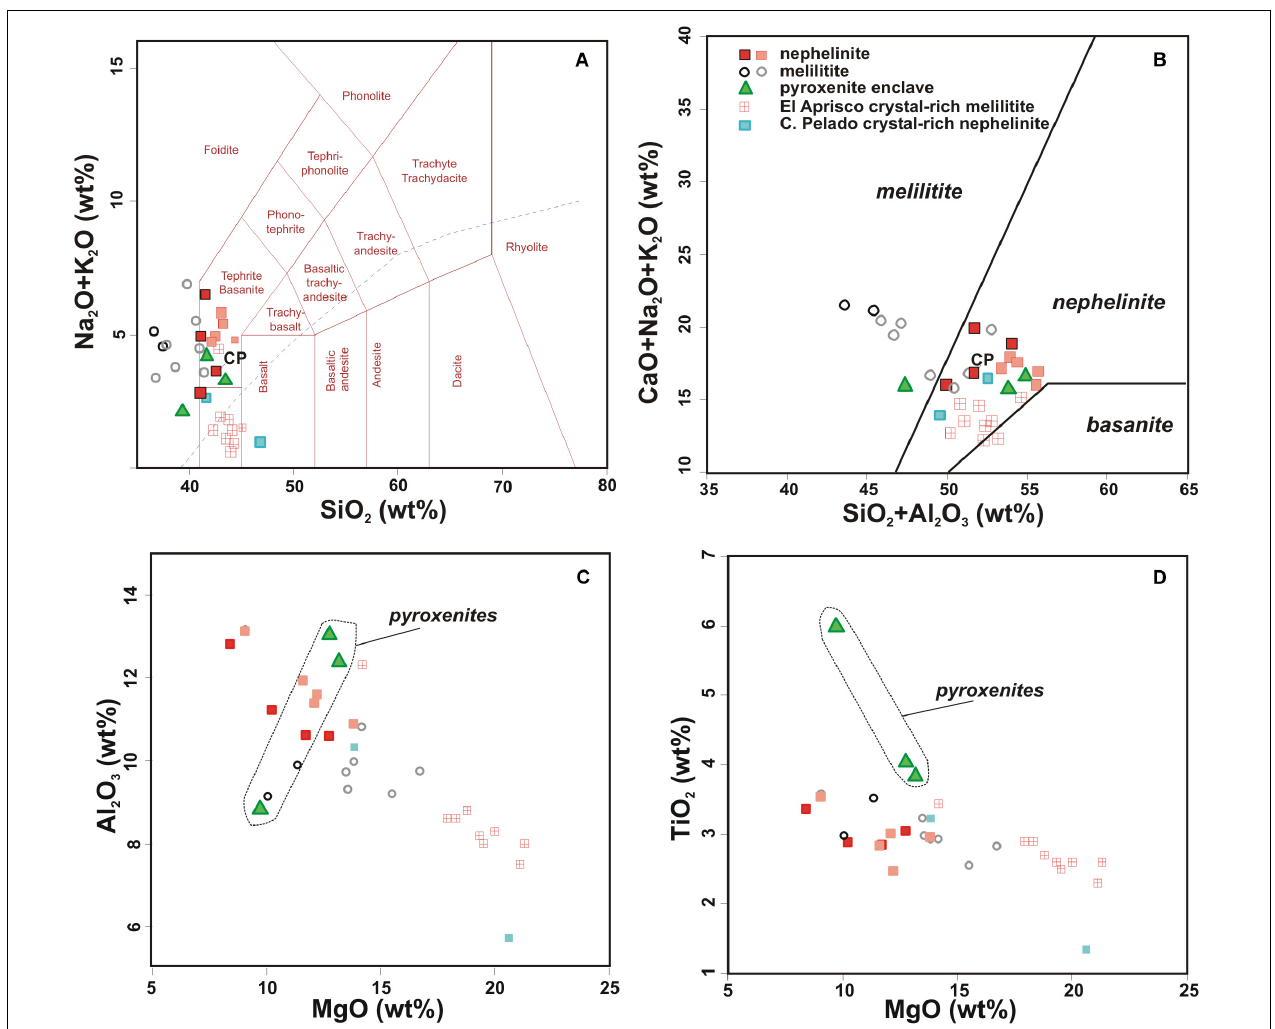
FIGURE 2 | Calatrava volcanic rocks in the TAS diagram (Le Maitre, 2002) (A) and in the nephelinite-melilitite-basanite classification of Le Bas (1989) (B) , showing a clear predominance of nephelinitic magma compositions in the studied volcanic rocks. Melilitite and nephelinite samples in gray color are from the literature